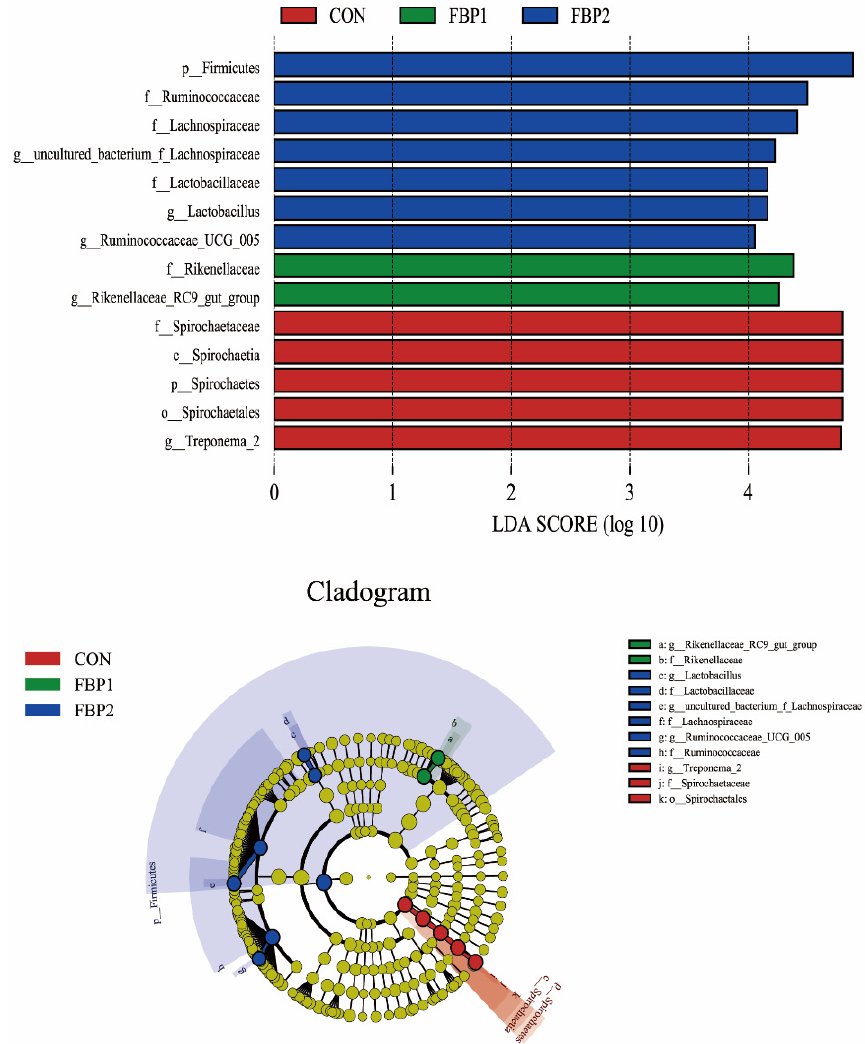
Figure 3. Linear discriminant analysis effect size (LEfSe) analysis ( p < 0.05, LDA > 4.0) of the fecal microbes. The prefixes “p”, “c”, “o”, “f”, and “g” represent the annotated level of phylum, class, order, family, and genus. CON, control diet. FBP1, the 5% fermented bamboo powder supplementation diet. FBP2, the 10% fermented bamboo powder supplementation diet.